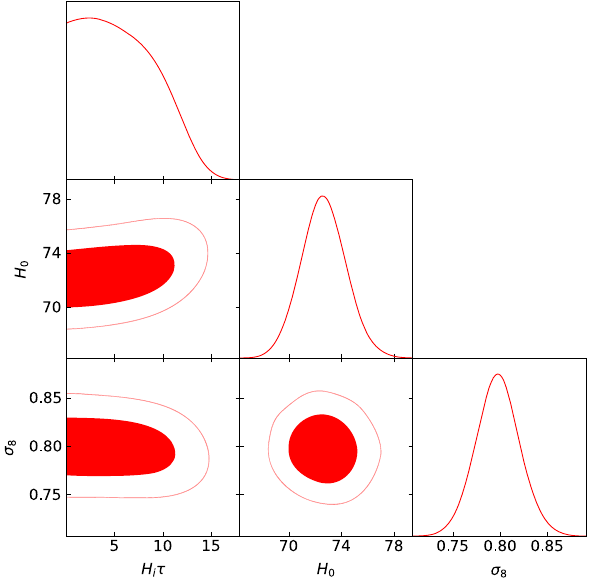
Fig. 17 Marginalized posterior distributions of the time delay param- eter τ , the Hubble constant H 0 , and σ 8 using the combined back- groundandgrowthdatasets.Themedianestimatesare H i τ = 5 . 55 + 4 . 57 − 3 . 76 or τ = 0 . 0993 + 0 . 0799 − Gyr, H 0 = 72 . 58 + 1 . 75 − km s − 1 Mpc − 1 , and 0 . 0664 1 . 67 σ = 0 . 80 ± 0 . 8